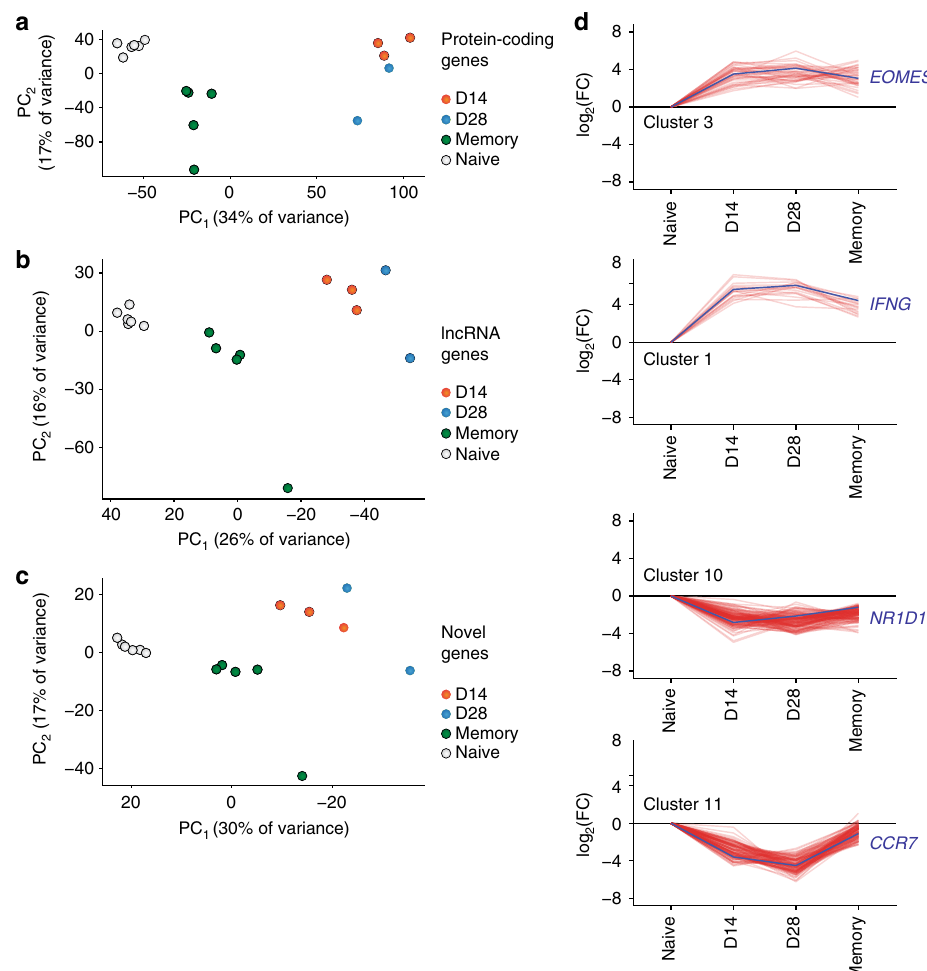
Fig. 6 Unique lncRNA expression patterns de fi ne time points of human CD8 + T cell differentiation. a Principal component analysis (PCA) of all human yellow fever-speci fi c CD8 + T cell samples, using only protein-coding genes. b PCA of human yellow fever-speci fi c CD8 + T cell subsets, using only noncoding genes, recapitulates the PCA of protein-coding genes. c Likewise, expression of novel lncRNAs is suf fi cient to discriminate CD8 + T cell subsets. d Unsupervised clustering revealed distinct expression patterns of lncRNA genes; lncRNA genes (red) and an exemplar protein-coding gene (blue) are shown for selected